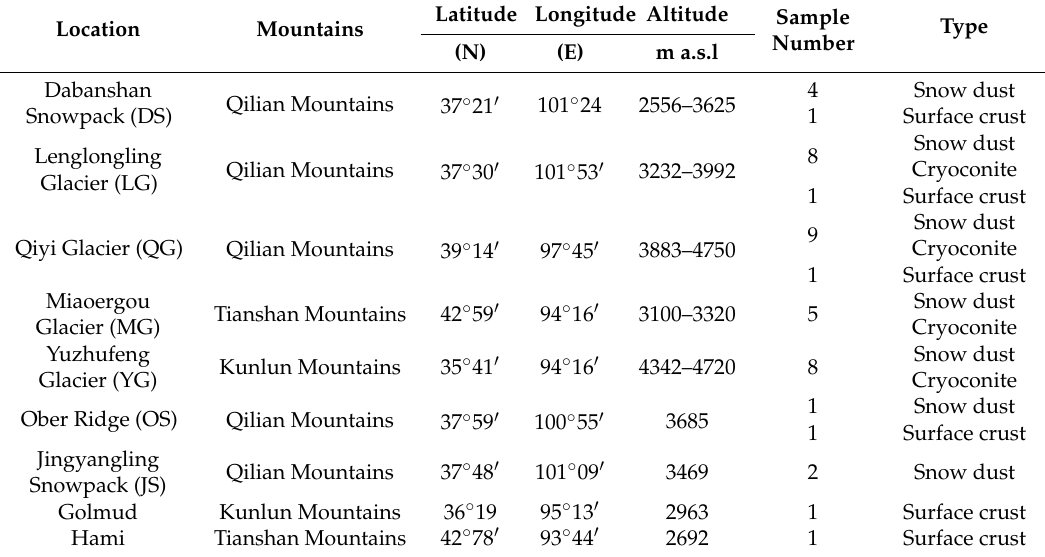
Figure 1. Location map showing the location of study area and sampling sites. MG, QG, YG, OS, JS, DS, and LG refer to Miaoergou Glacier, Qiyi Glacier, Yuzhufeng Glacier, Ober Ridge Snowpack, Jingyangling Snowpack, Dabanshan Snowpack and Lenglongling Glacier, respectively. Table 1. Description for cryoconite and surface snow dust sampled from the glacier and snowpacks in the NETP and eastern Tianshan Mountains.